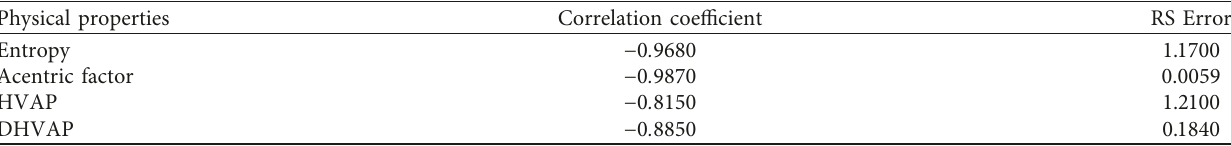
Table 2: GHI and parameters of regression models.